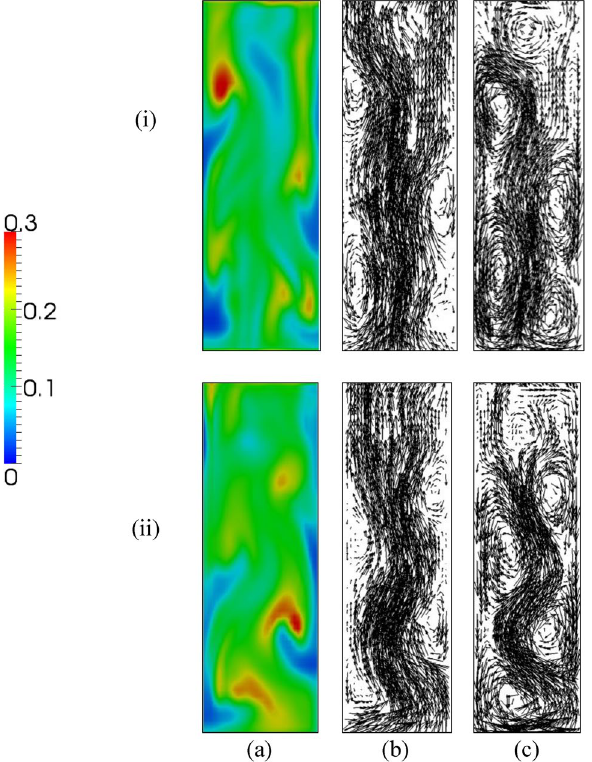
Fig. 11 Simulated a gas volume fraction distribution, b gas veloc- ity vectors and (c) liquid velocity vectors for uniform sparger A1 (100%) at (i) 4.3 cm/s and (ii) 5.8 cm/s using Re based